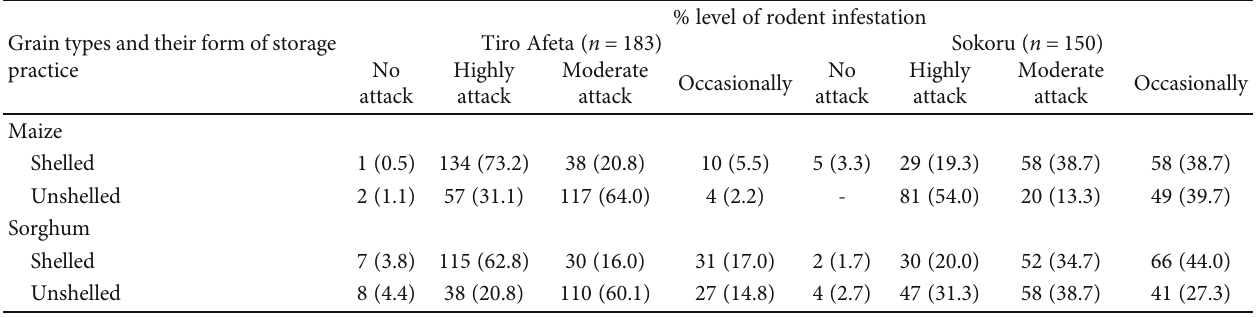
Table 4: Farmers ’ estimation level of rodent ’ s infestations on stored grain.